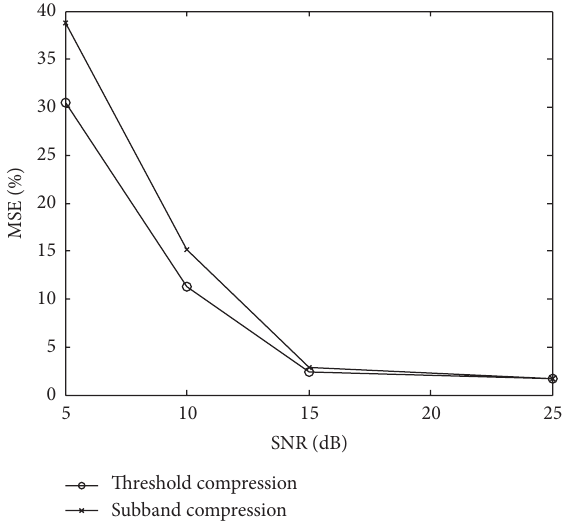
Figure 2: MSSIM metricversus SNR and different wavelet compres- sion methods with equal retained